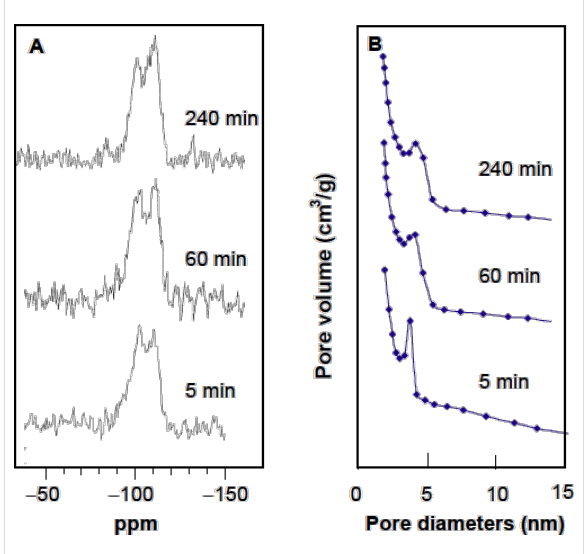
Figure 3: (A) Solid state 29 Si CP MAS NMR spectra of LPEI@silica hybrid nanotubes formed after silicification times of 5 min, 60 min and 240 min. The LPEI aggregates were prepared by first dropping 1.0 mL aqueous NaOH solution (5.0 M) into a mixture of 0.5 g of LPEI·HCl and 5 mL of water ([OH]/[EI] = 0.8), then washing the crystalline LPEI aggregates to pH 7.0 with centrifugation–redispersion cycles.